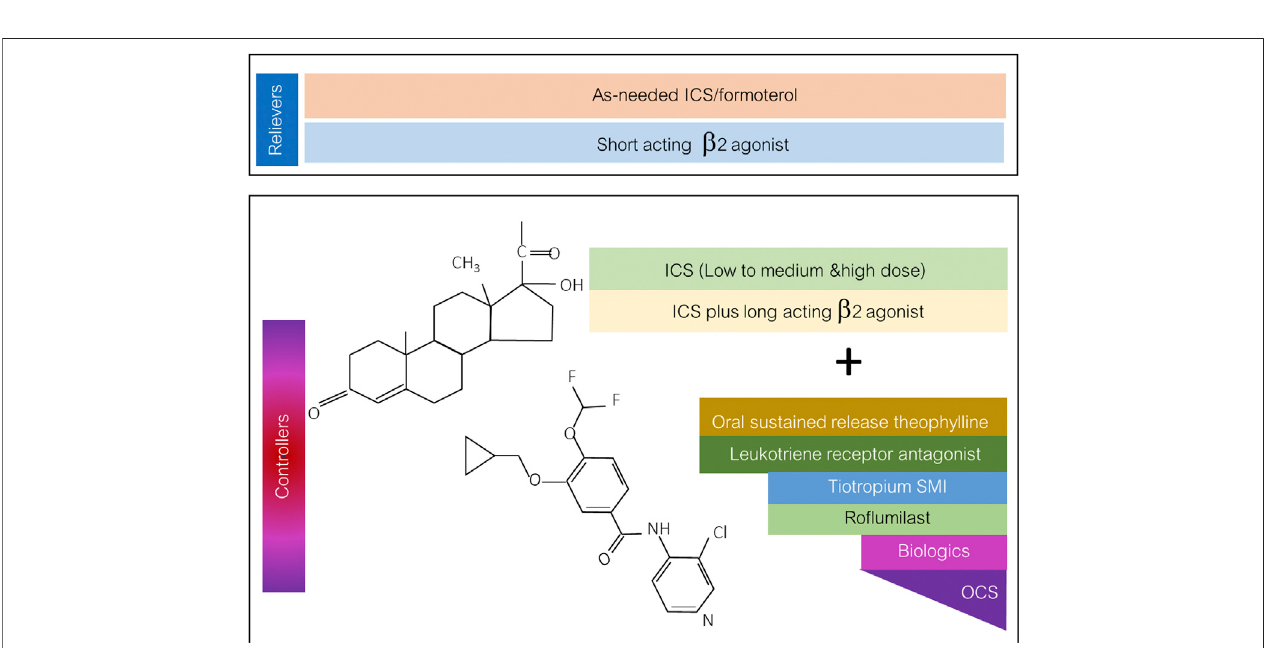
FIGURE 4 | Mechanisms of roflumilast in non-CF bronchiectasis for both modulating in fl ammatory cells and enhancing structural cell function of bronchiectasis.